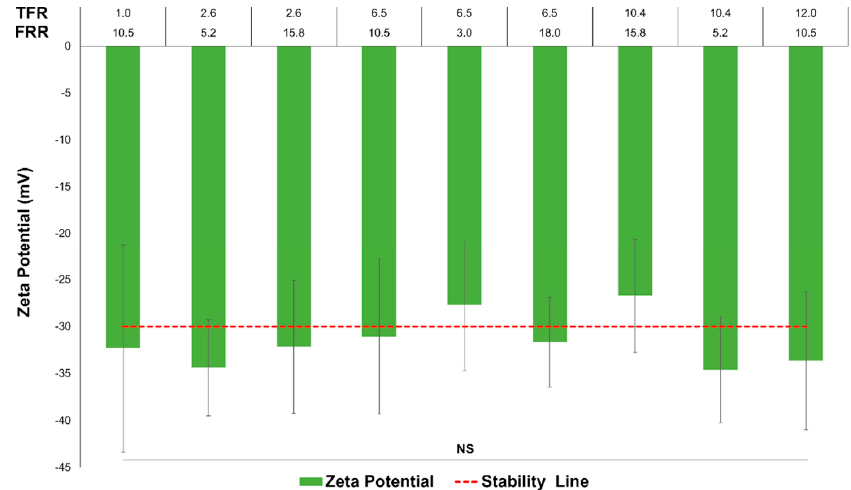
Figure 5. Zeta potential measurements result for the nine different conditions. The x ‐ axis values correspond to TFR on the top and FRR on the bottom. The red line marks the stability line for particle dispersions ( +/ − 30 mV). The error bars show 1.96 σ , indicating the limits of 95% confidence.